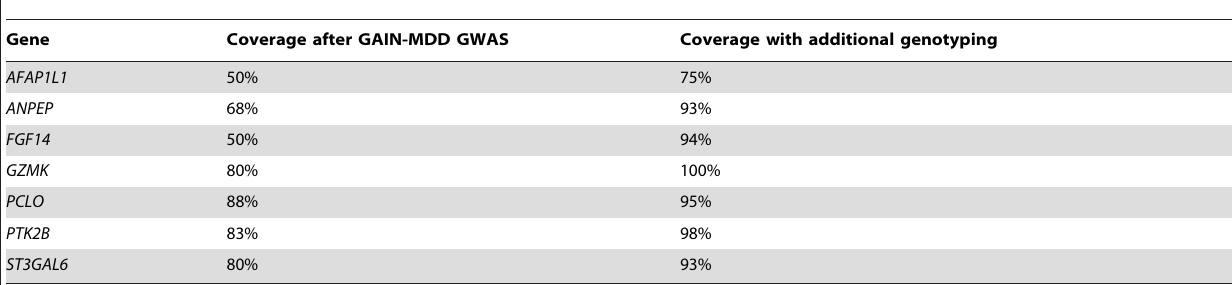
Table 2. Coverage calculated for each gene at r 2 . 0.8 m.a.f. . 0.1 before and after fine mapping.